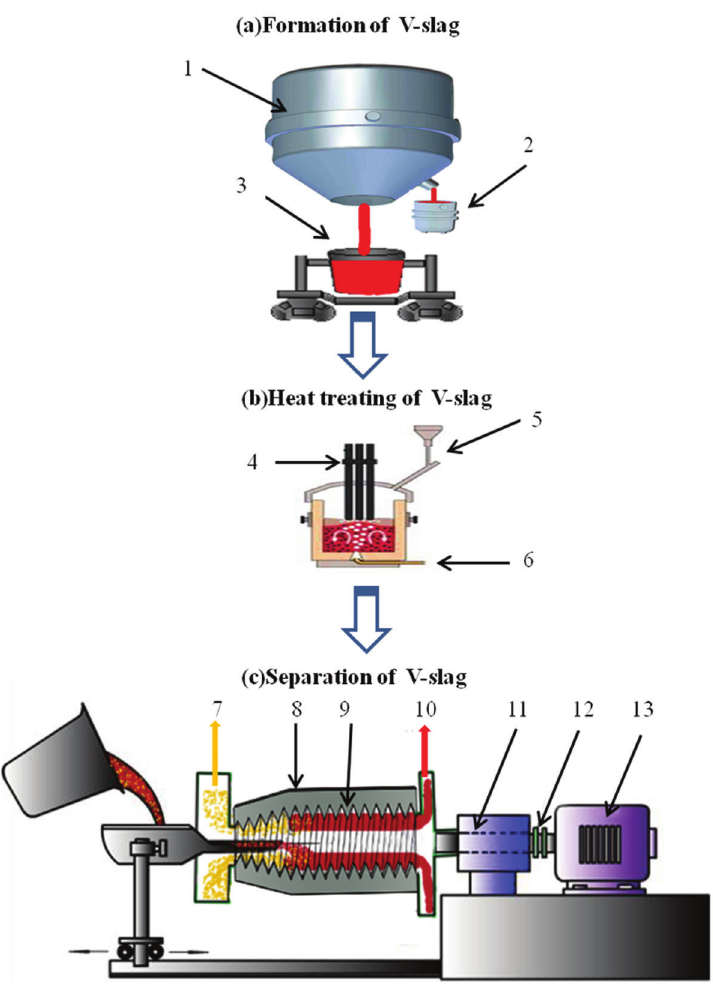
Fig. 1: Flow diagram to effectively utilize the vanadium slag. 1. Oxygen converter; 2. Ladle; 3. Slag ladle; 4. Heating systerm; 5. Feeding systerm; 6. Bottom blowing systerm; 7. V-containing spinel crystals; 8. Rotating drum; 9. Screw conveyor; 10. Tailing; 11. Bearing; 12. Coupling; 13.